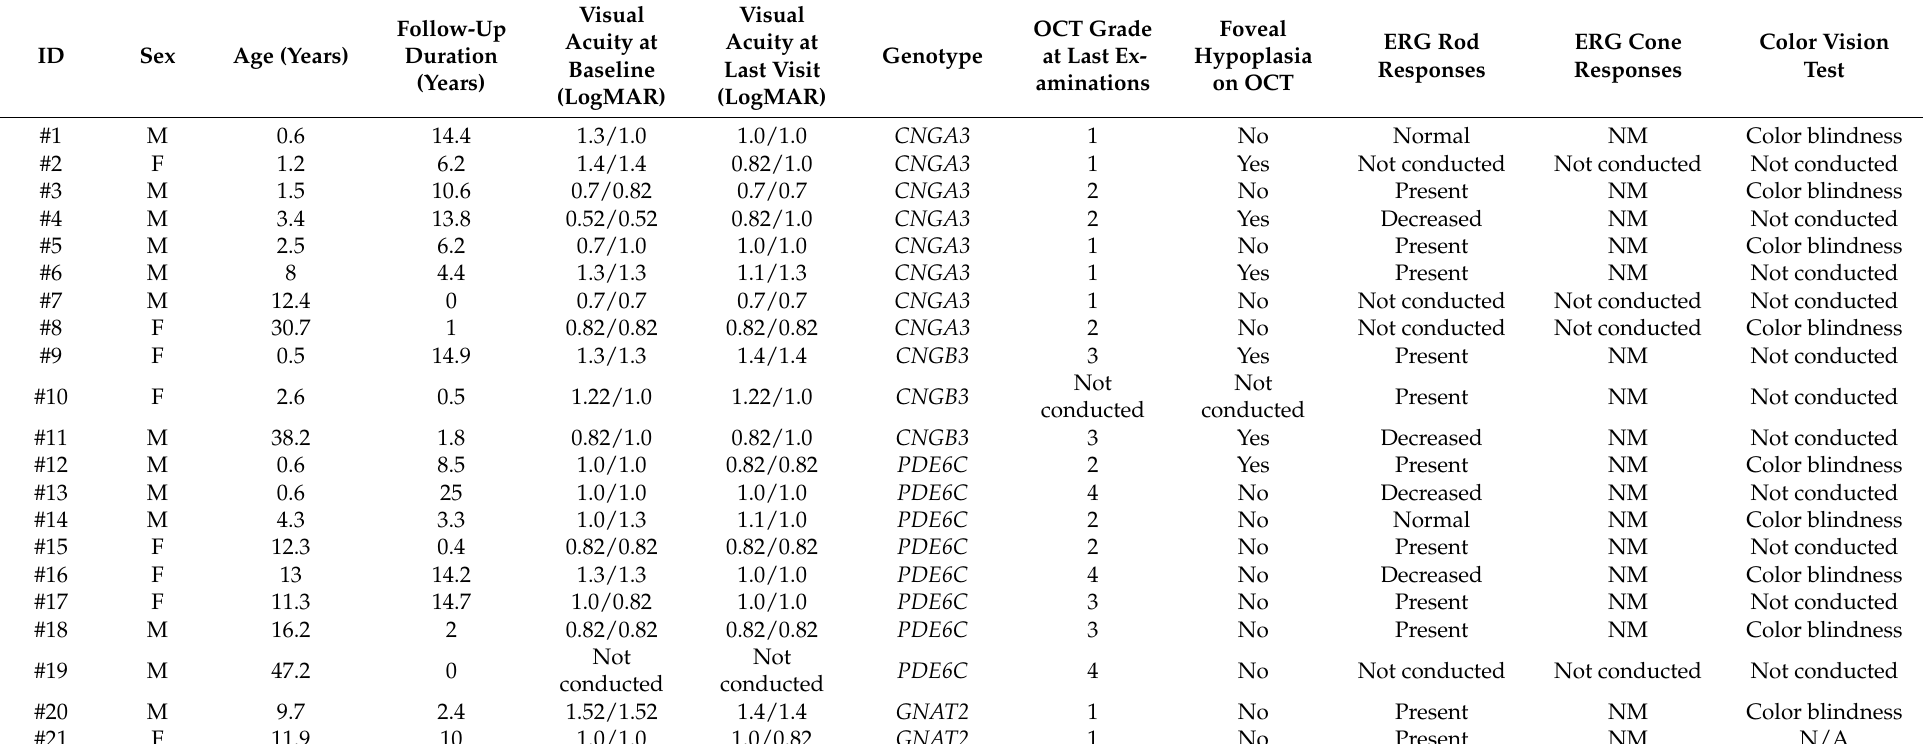
Table 1. Clinical features and patient